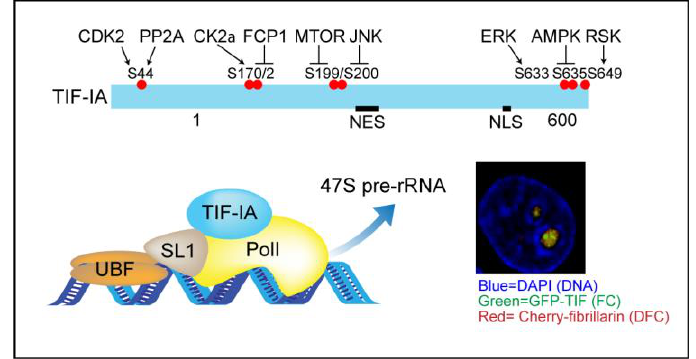
Figure 1. Top: TIF-IA is targeted by multiple kinase and phosphatase pathways. Bottom: the phosphorylation status controls the transcriptional activity of the pre-initiation complex, of which TIF-IA is a vital component. NES-nuclear export signal. NLS-nuclear localisation signal. Insert; confocal image showing the localisation of GFP-TIF-IA in fibrillar centres (FC) of nucleoli and cherry-fibrillarin in the surrounding dense fibrillar component (DFC) in fixed colorectal cancer cells. DAPI marks the DNA. Nuceloi are divided into three sub-compartments namely; fibrillar centres (FC), dense fibrillar component (DFC), and granular component (GC). Transcription of rDNA takes place at the interface between FCs and DFCs while maturation takes place in the DFC and GC. Ribosomal DNA arrays